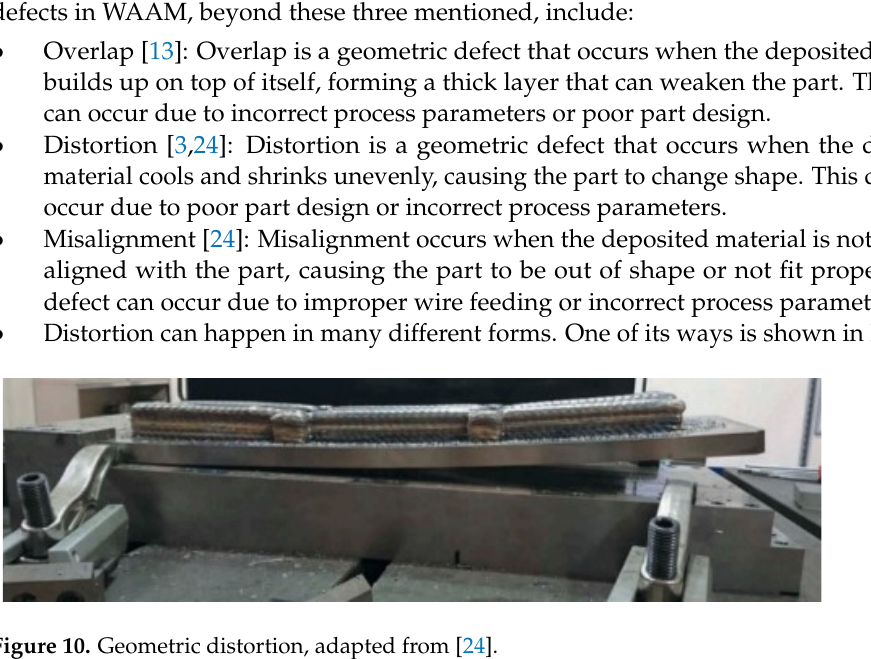
Figure 9. Uneven bead height, adapted from